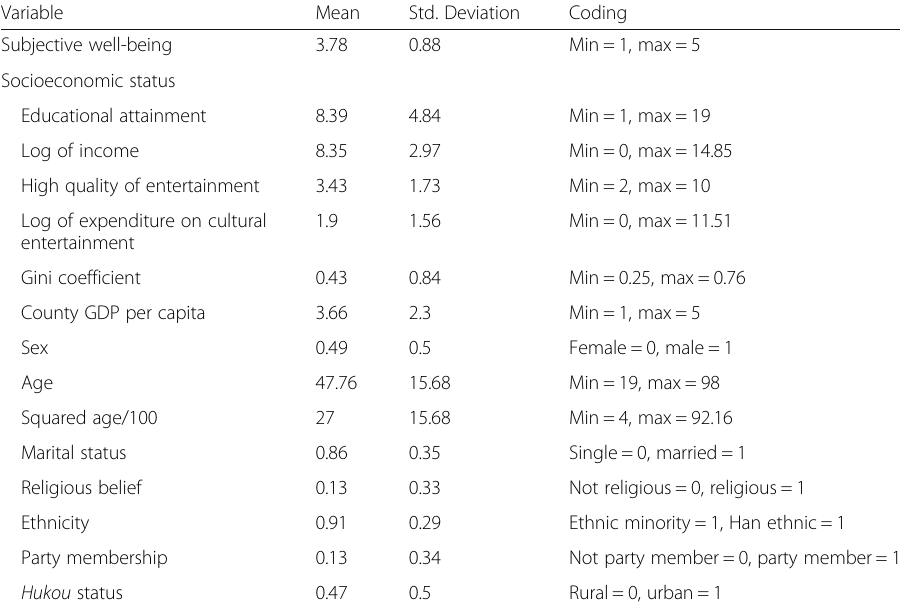
Table 1 Descriptive statistics